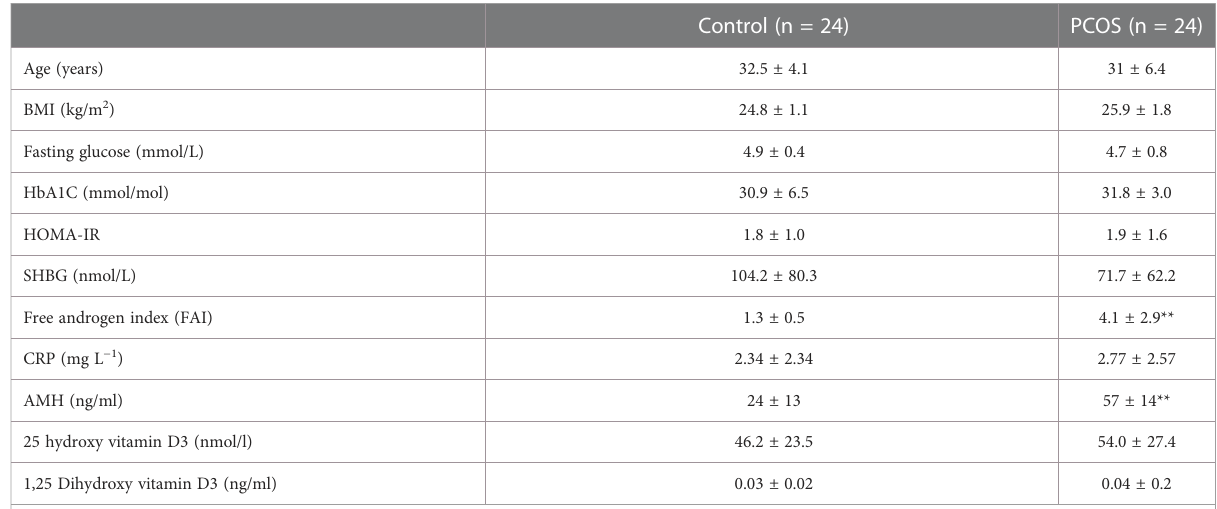
TABLE 1 Demographics, baseline, hormonal, and metabolic parameters of the women with PCOS and control women (mean ± SD). All parameters did not differ other than those marked **=p